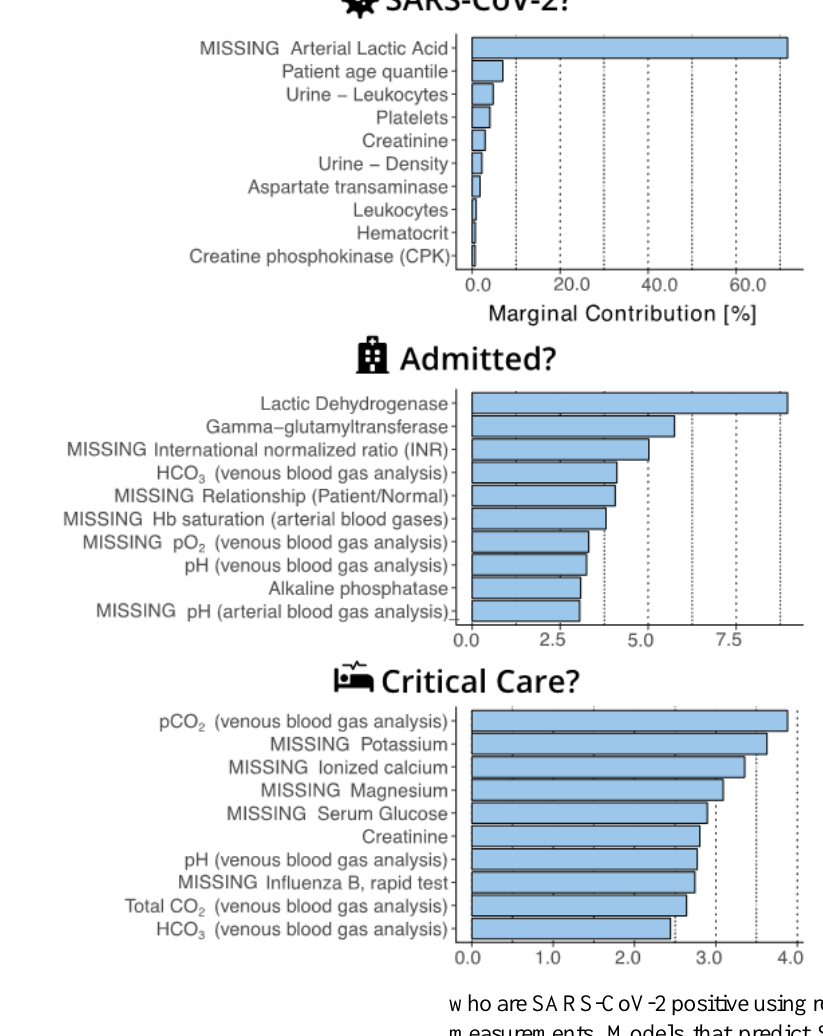
Figure 3. A comparison of the top 10 features ranked by relative feature importance scores for the best-encountered model for predicting SARS-CoV-2 test results (gradient boosting, top), hospital admissions (random forest, middle), and critical care admission for patients who are SARS-CoV-2 positive (support vector machine, bottom), respectively. The bar length corresponds to the relative marginal importance (in %) of the displayed features toward the predictive performance of the respective model. Feature names that include “MISSING” indicate that the given marginal contribution refers to the importance of the presence of that feature's absence, not the feature